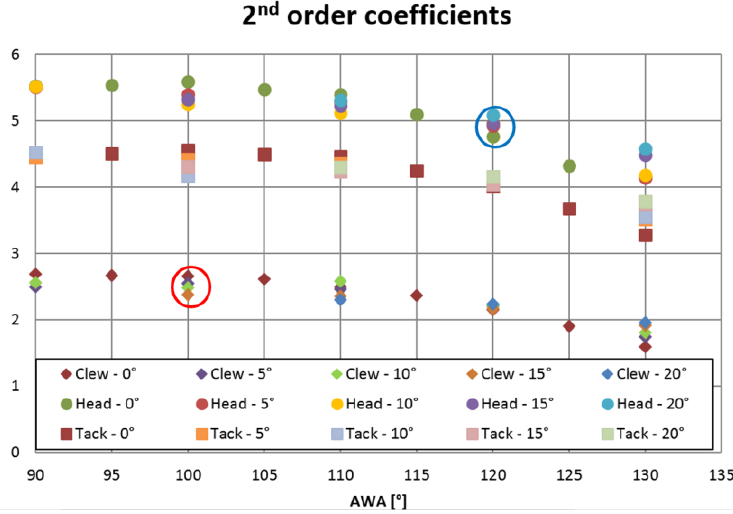
Figure 18. Plots of second order coefficients vs. AWA at different values of Δ α g .